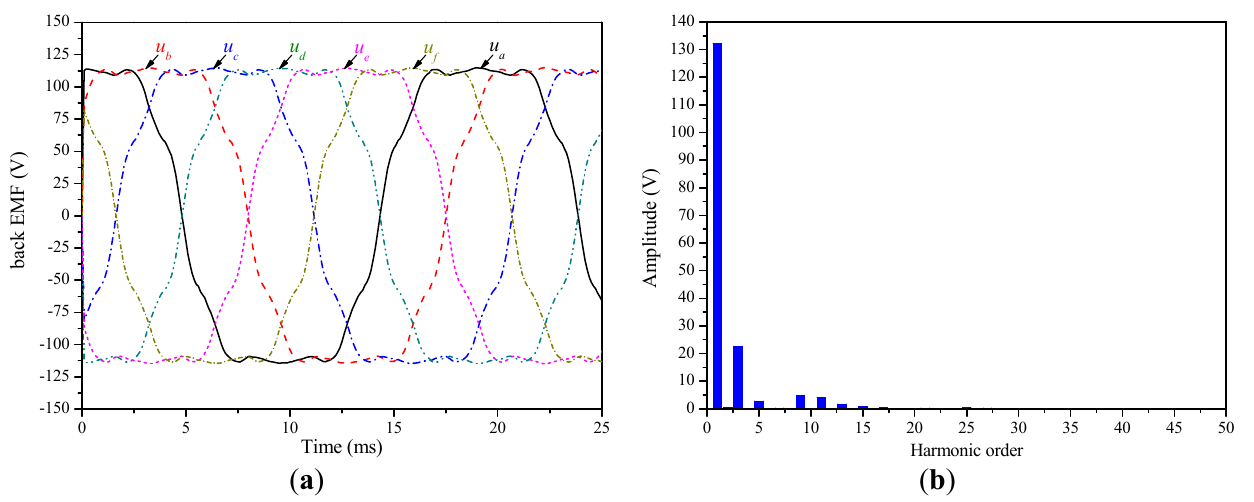
Figure 12. Back EMF waveform@450 rpm: ( a ) six-phase back EMF; and ( b ) spectrum for the back EMF in phase